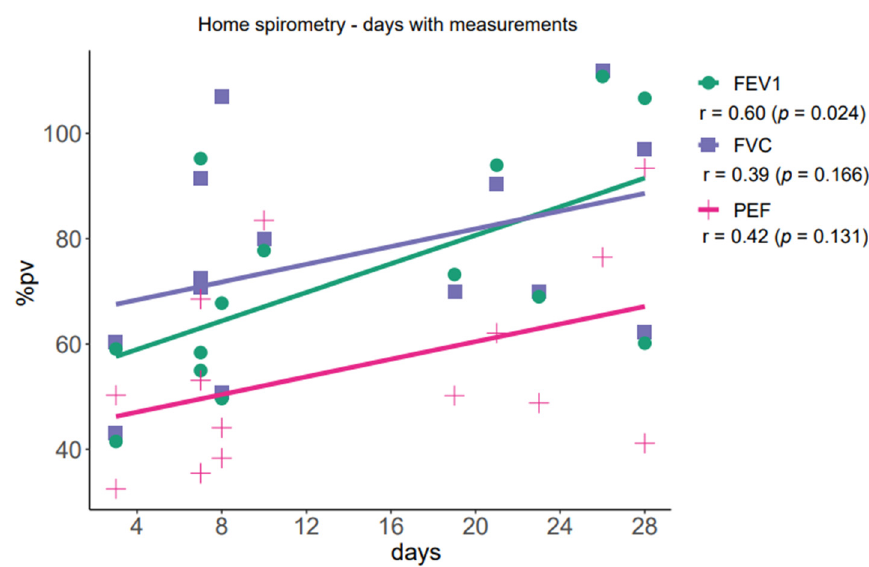
Figure 2. Correlation between number of days of measurements and pulmonary function tests. FVC, forced vital capacity; FEV1, forced expiratory volume in 1 s; PEF, peak expiratory flow.